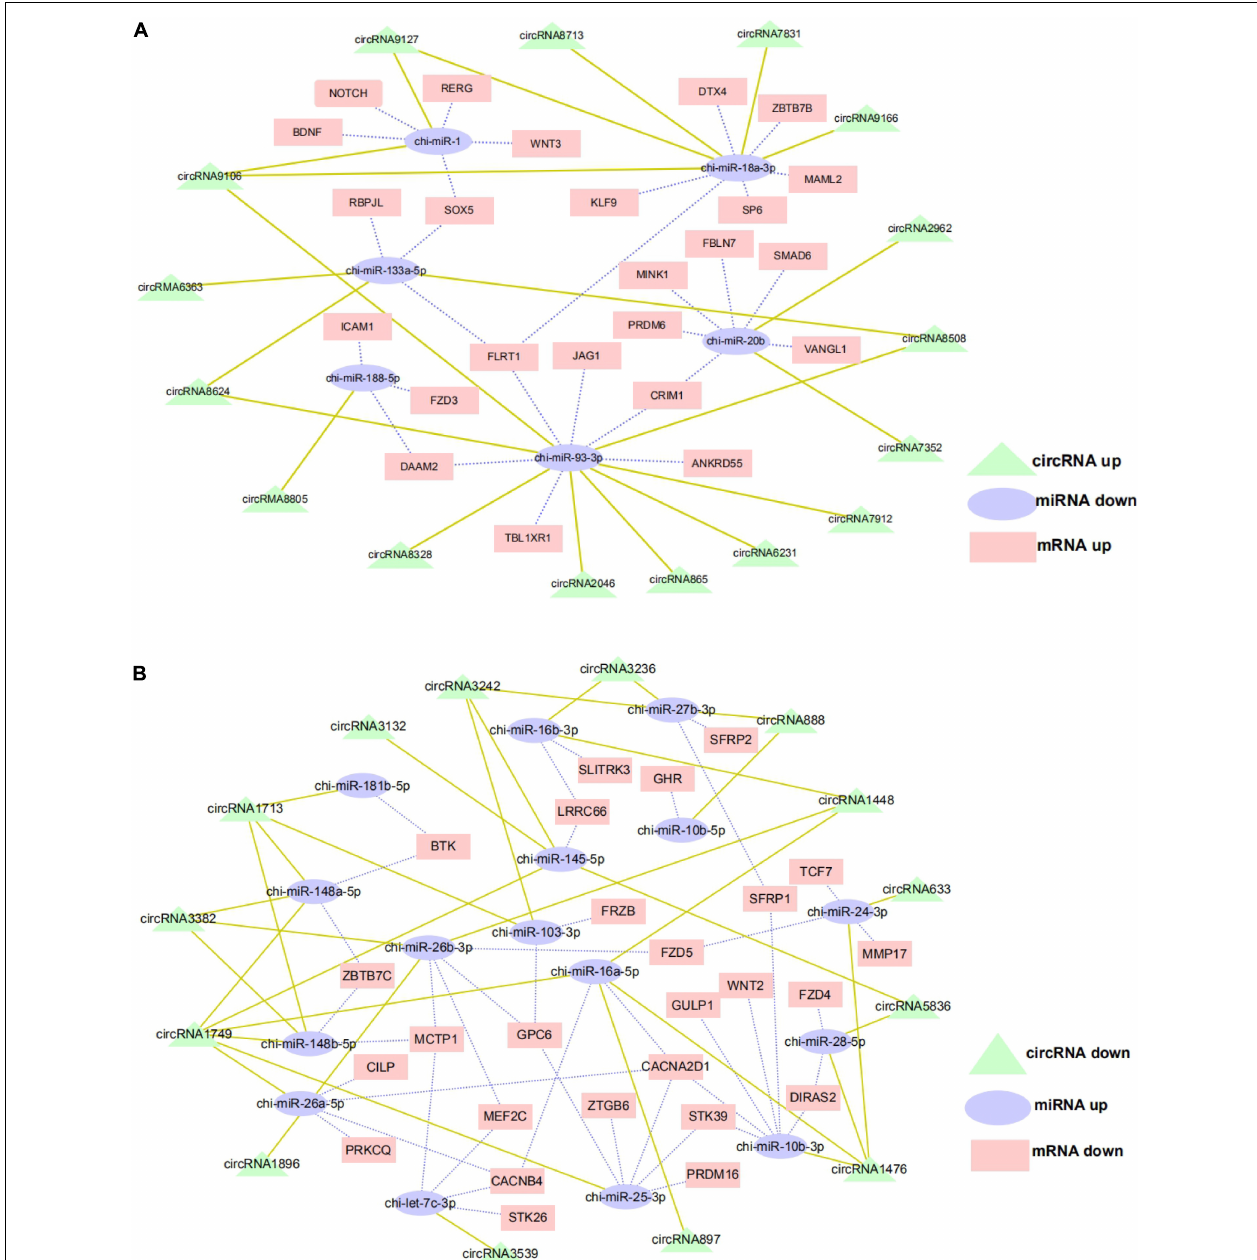
FIGURE 6 | CircRNA–miRNA–mRNA regulatory network analysis in cashmere goat hair follicle. (A) Upregulated circRNA networks and (B) downregulated circRNAs networks for